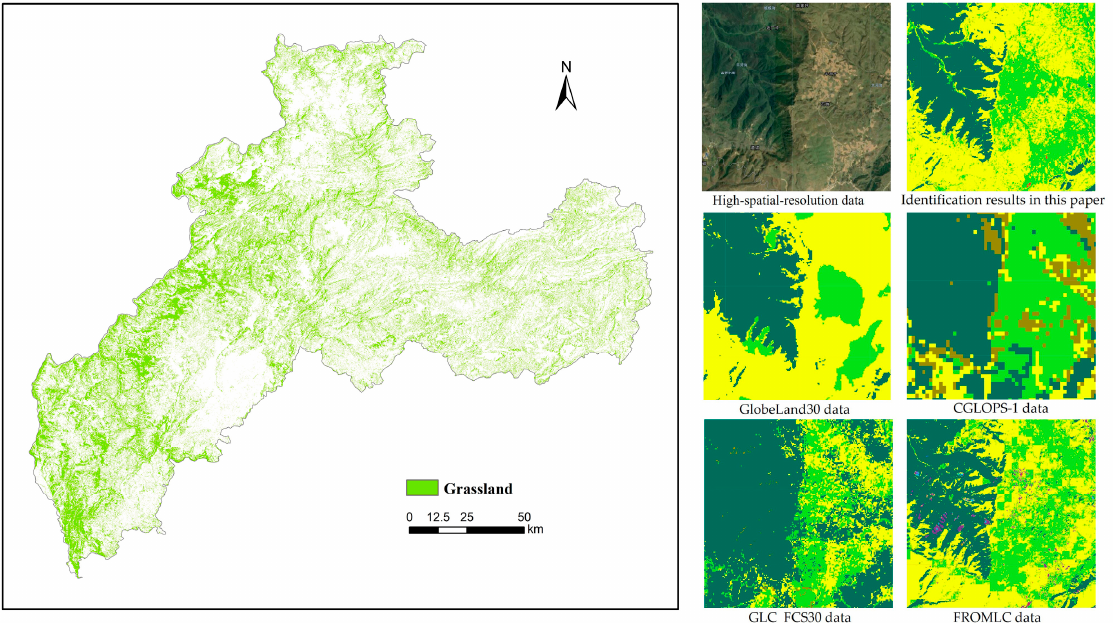
Figure 3. Remote Sensing identi fi cation map (10 m) of grassland distribution in Zhaotong in 2020.